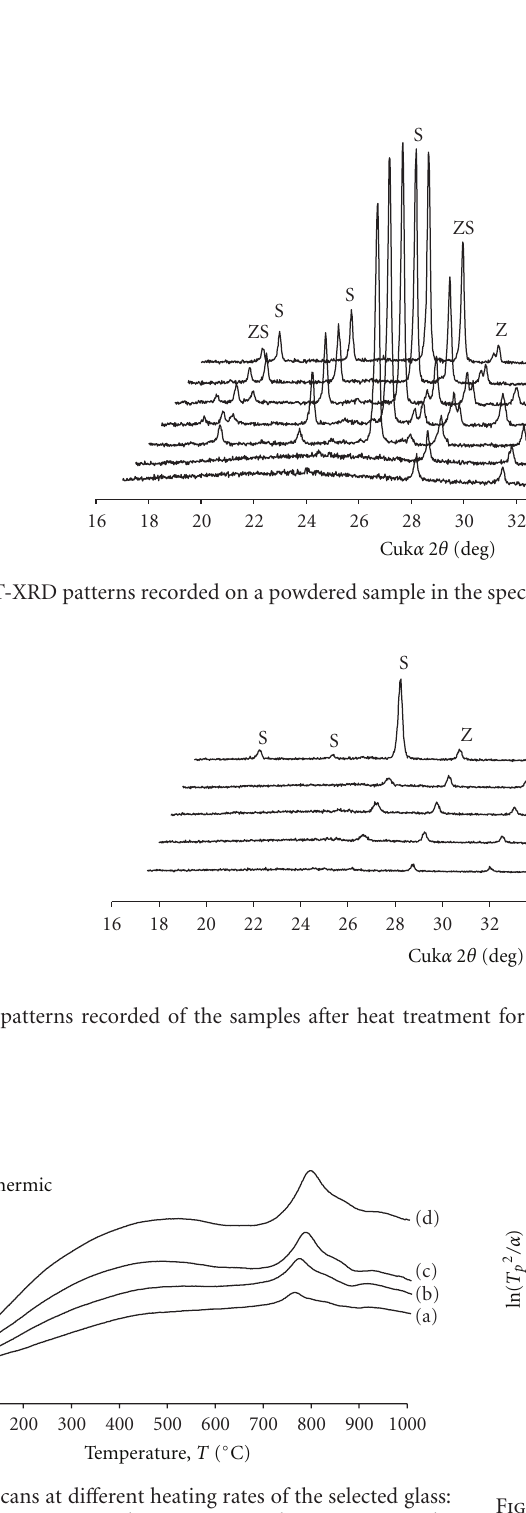
Figure 8: Apparent activation energy for crystallization plot for the selected glass based on (2) with n = m =